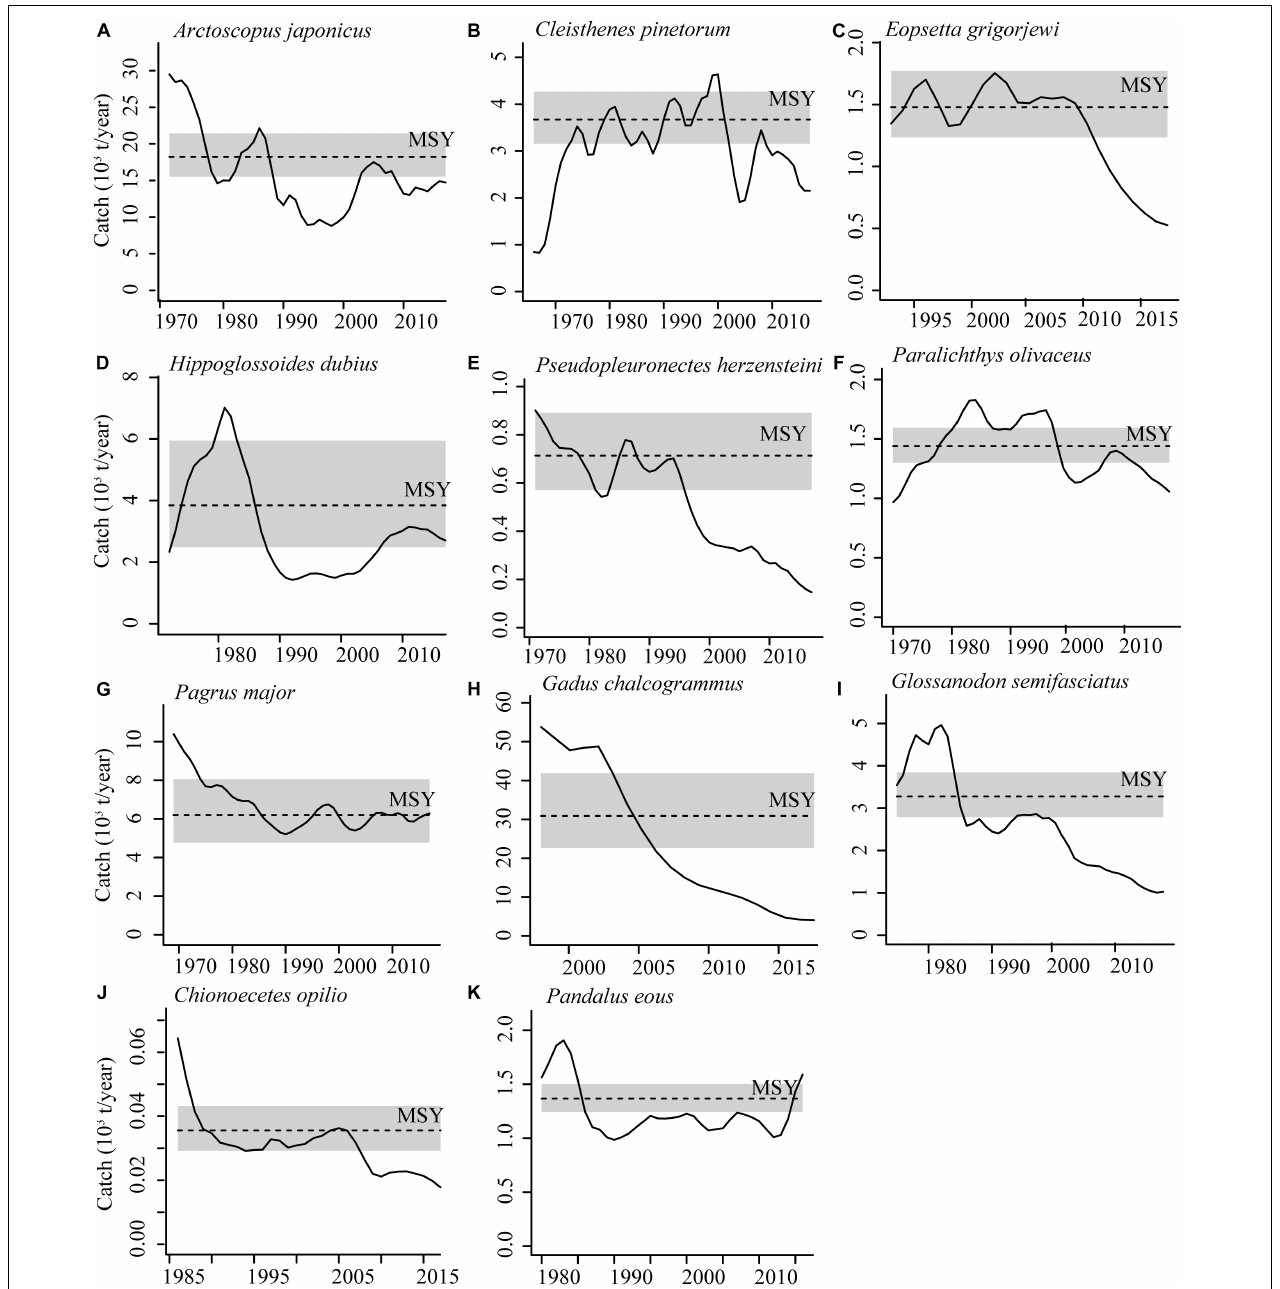
FIGURE 3 | Trajectories of catch of 11 stocks in the Japan